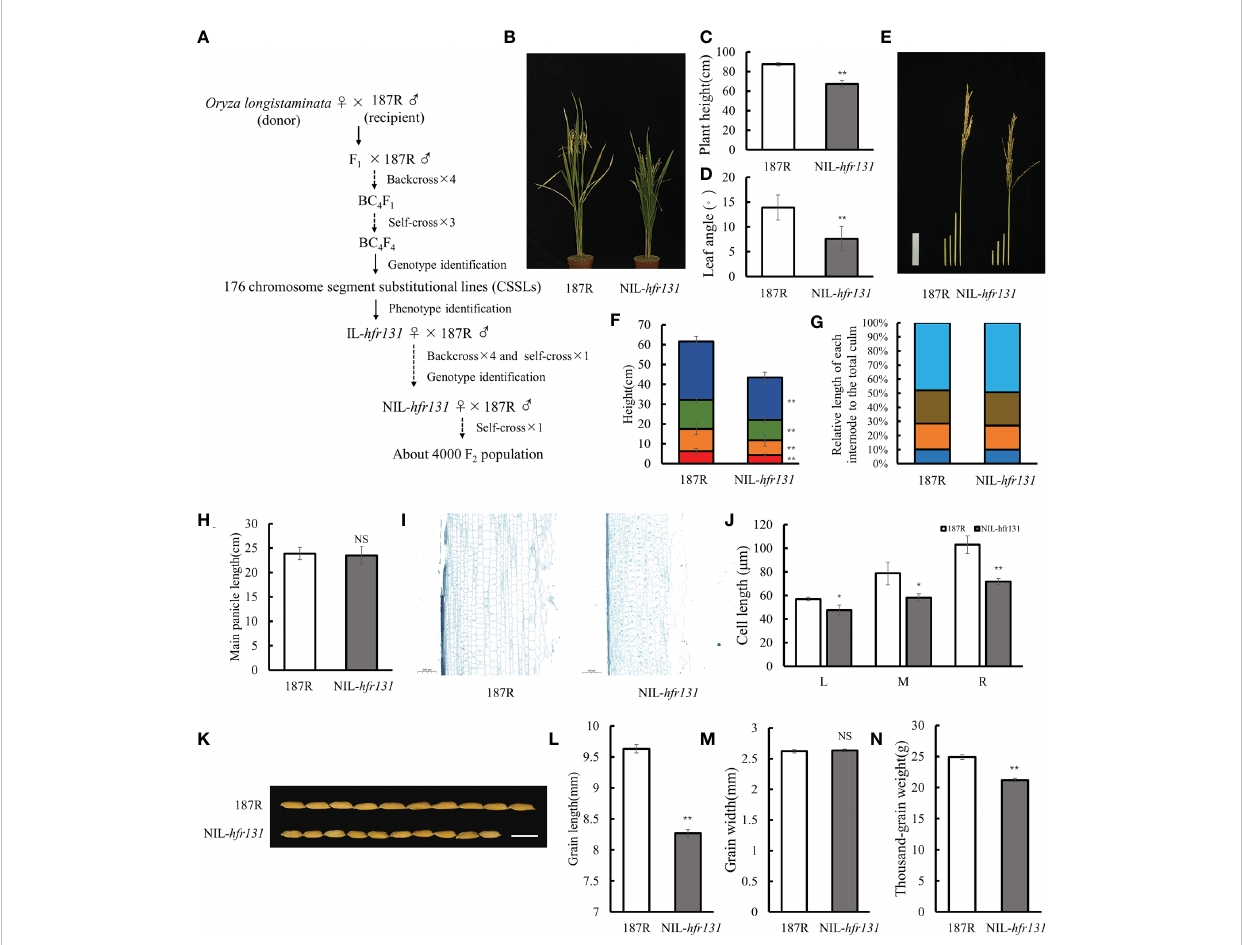
FIGURE 1 Phenotypes of rice ‘ 187R ’ and NIL- hfr131 . (A) Construction of in fi ltrating lines and F 2 population. (B – D) Plant architecture, plant height, and the third leaf angle of 187R and NIL- hfr131 . (E – G) Internode morphology (bar = 10 cm), internode length, and internode elongation pattern of 187R and NIL- hfr131 . (H) Panicle length of 187R and NIL- hfr131 . (I, J) Longitudinal sections of the stem and internode cell length (L, M, and R refer to the left, middle, and right side of the section, respectively) of 187R and NIL- hfr131 (bar = 200 m m). (K – N) Grain morphology (bar = 1 cm), grain length, grain width, and thousand-grain weight of 187R and NIL- hfr131 . * P < 0.05, ** P < 0.01, NS non-signi fi